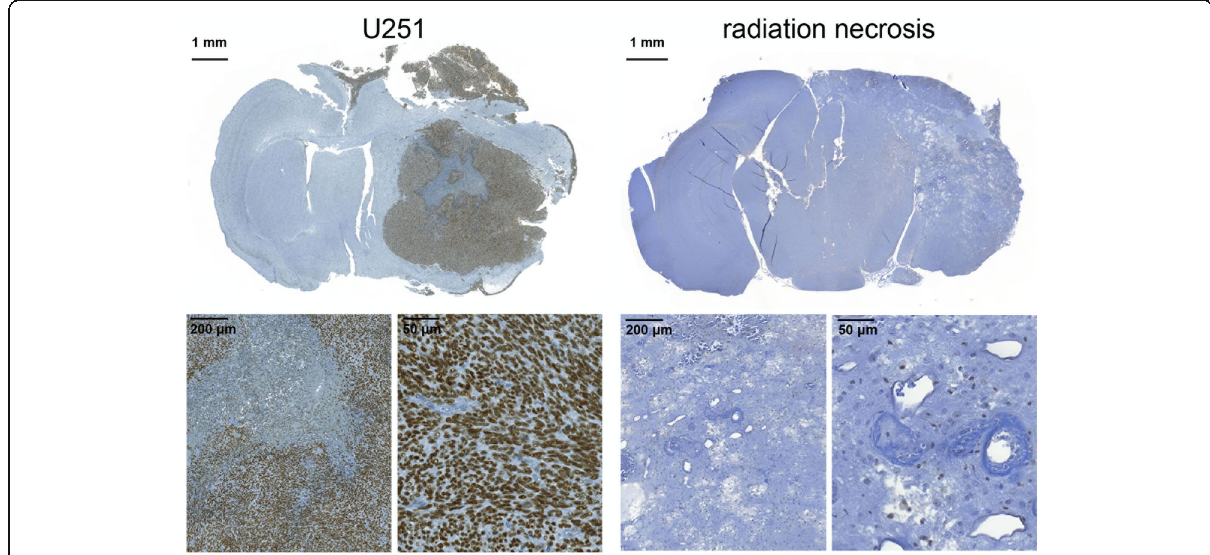
Fig. 2 Anti-PARP1 immunohistochemistry. Staining of transaxial formalin-fixed, paraffin-embedded sections of mice implanted with U251 tumors (left group) mice with experimental radiation necrosis (right group) reveals high PARP1 expression in the nuclei of tumor cells and low PARP1 expression elsewhere in healthy brain and radiation